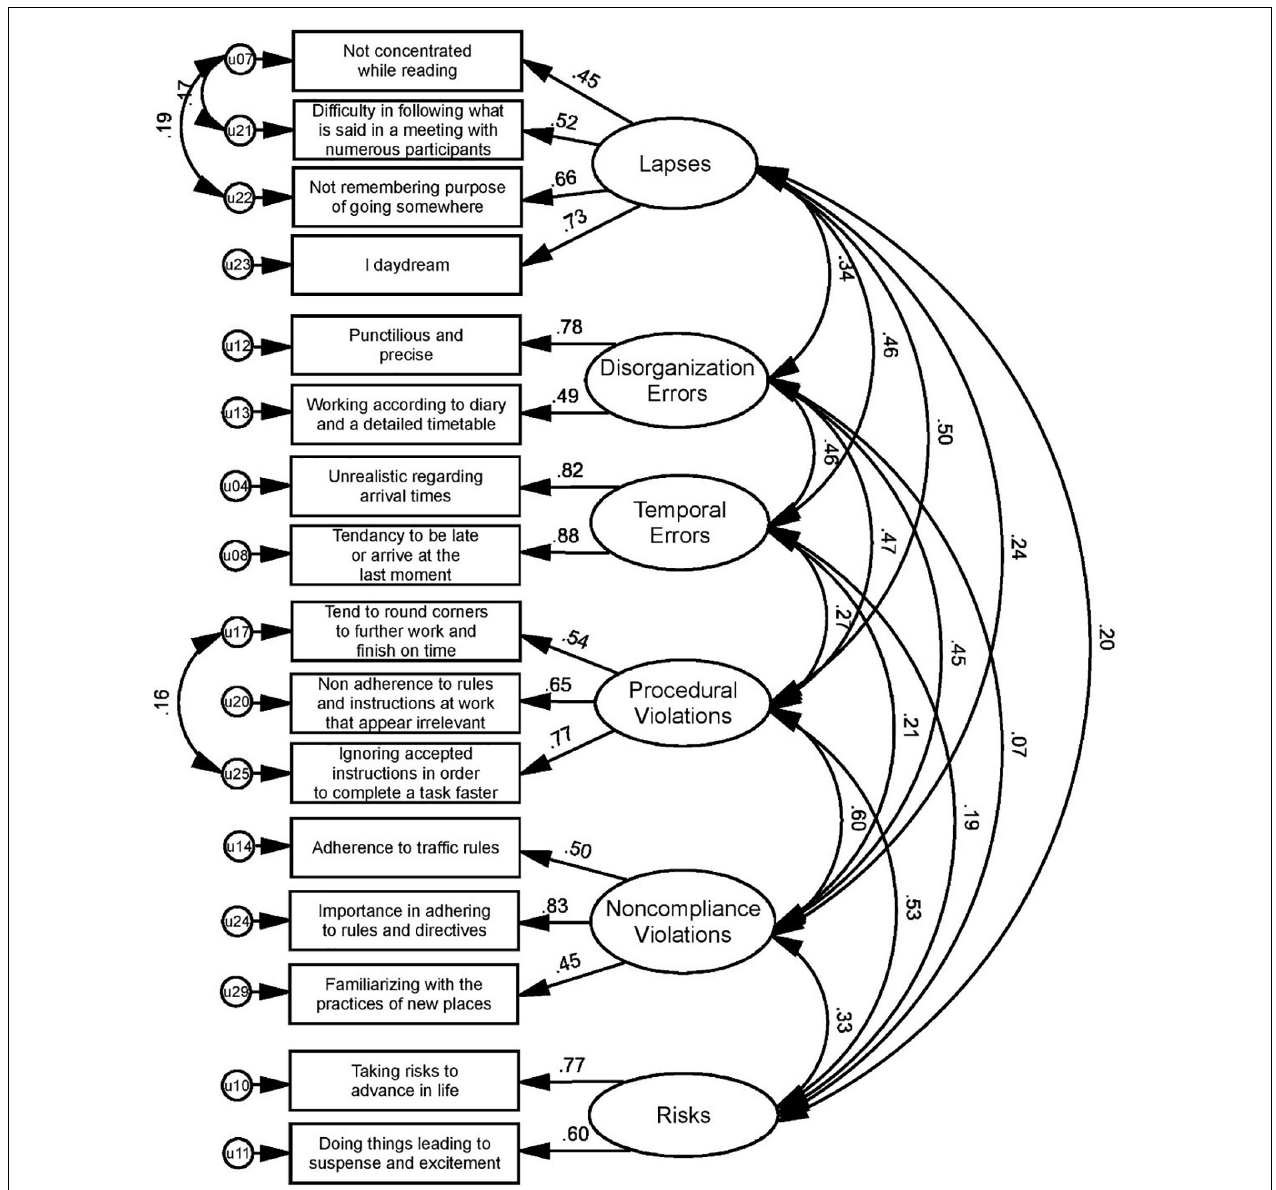
FIGURE 1 | Factor loadings using the 16-item final FP solution and correlations between FP